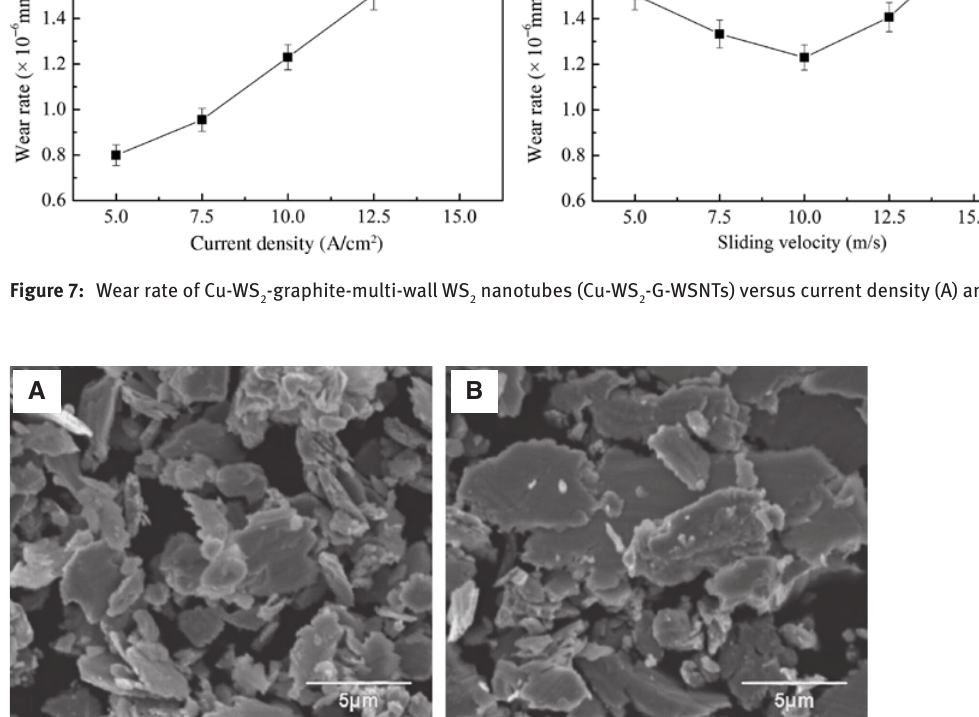
Figure 8: Scanning electron microscopy (SEM) micrographs of wear debris of Cu-WS under various current densities with 2.5 N/cm 2 of applied load and 10 m/s of sliding velocity: (A) 5 A/cm 2 ; (B) 15 A/cm 2